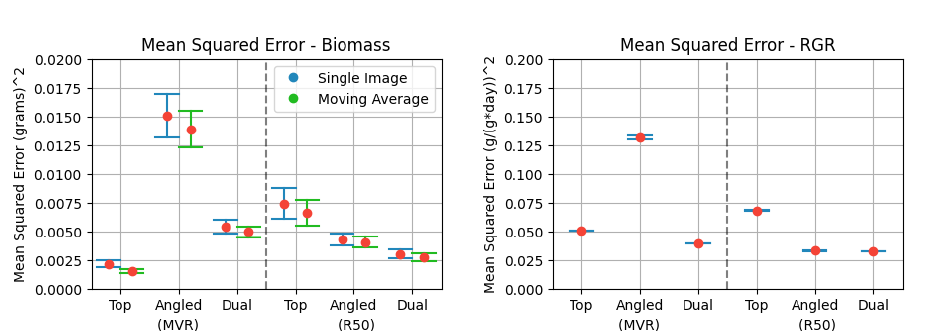
Figure 7. Confidence intervals (95%) for mean square errors in prediction on the test set using MVR or R-50 based network, with respect to camera view (top, angled, or dual). ( Left ): Biomass predictions in tasks Single Image and Moving Average. ( Right ): RGR predictions in task